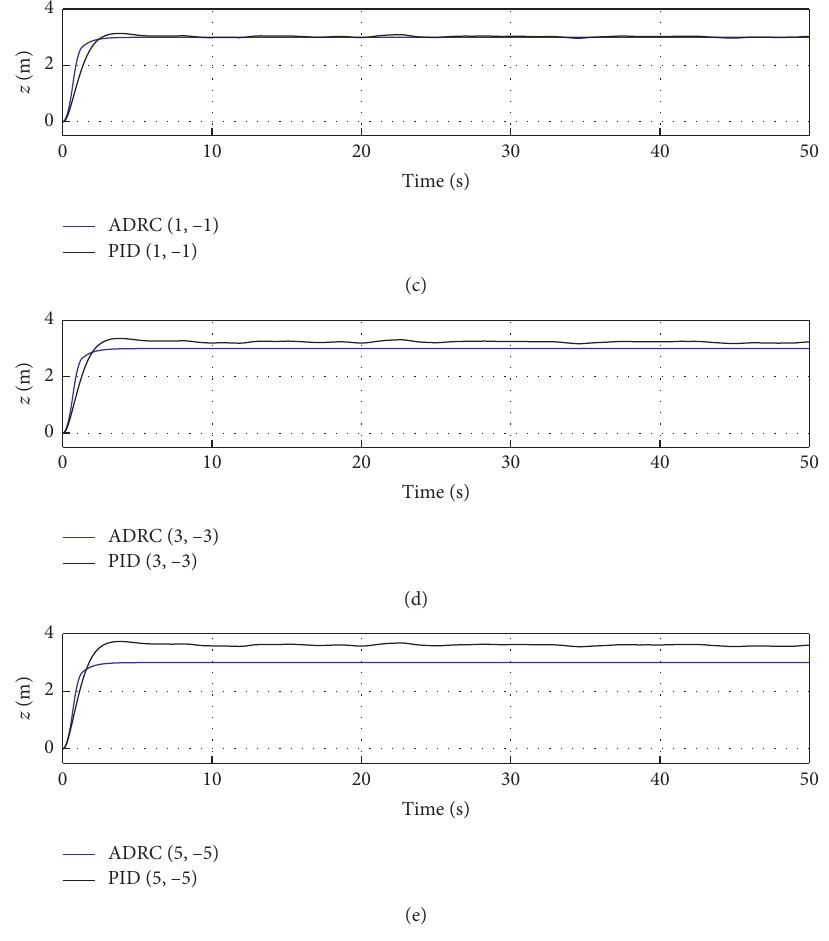
Figure 14: Curve of z under wind and without wind.